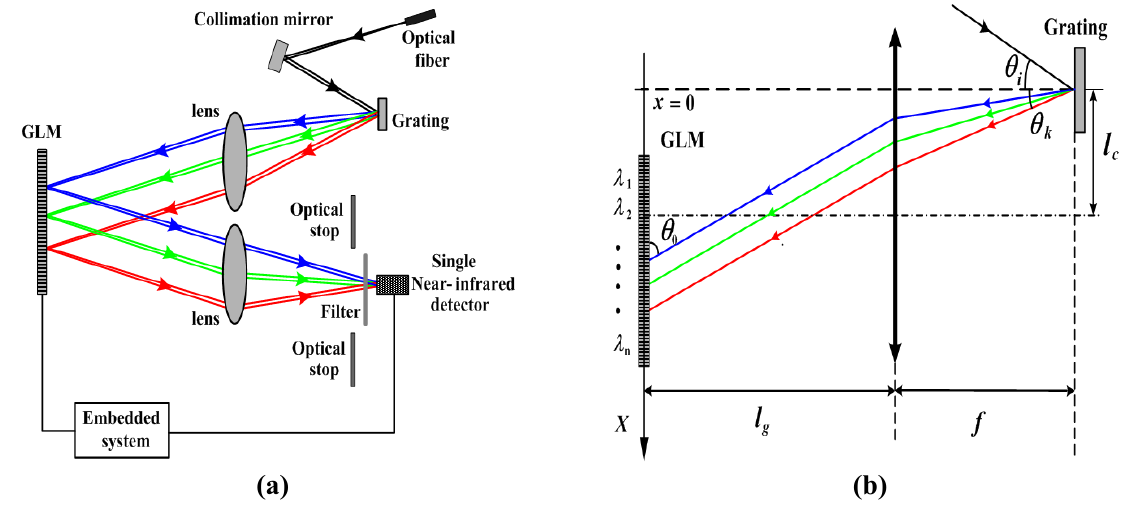
Figure 1. (a) Architecture of spectrometer (b) Position relationship among GLM, lens and fixed